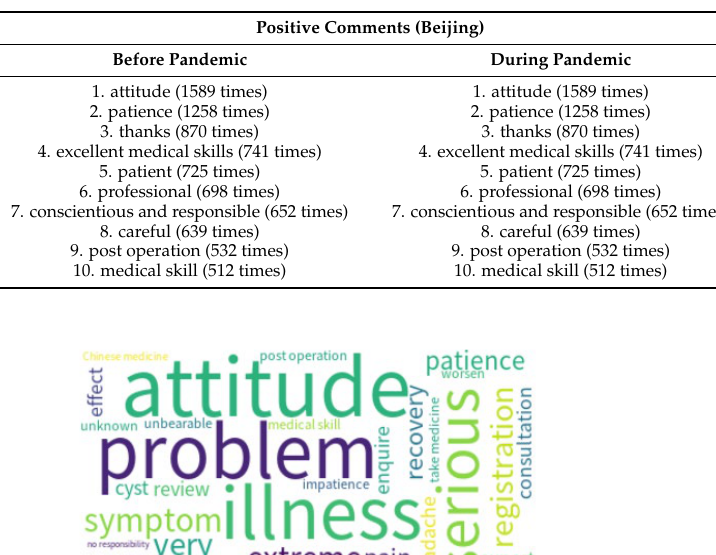
Table 5. Frequently Used Words in Comments (Beijing).